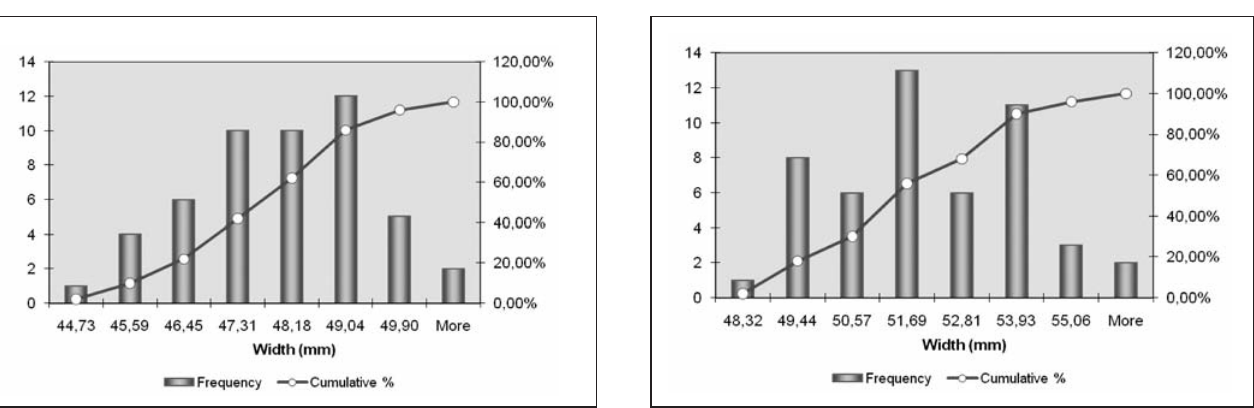
Fig. 22: Distribution of the width values of category AA of Jumbo Cot Fig. 23: Distribution of the width values of category AAA of Jumbo